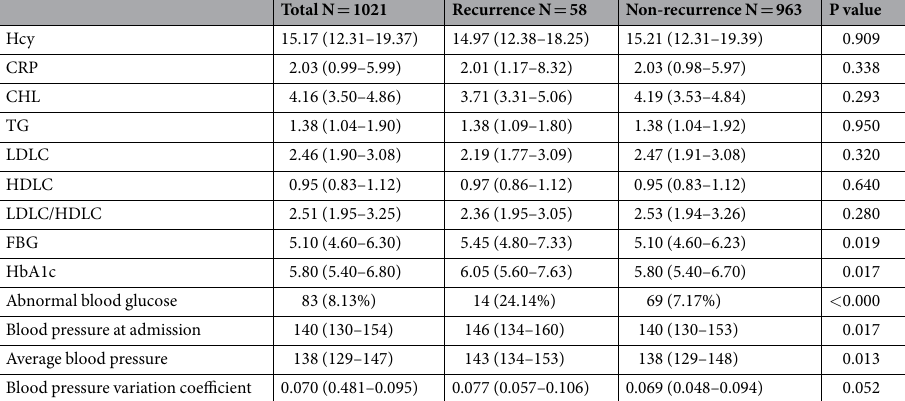
Table 4. Comparison of the serology results and blood pressure between the two groups of patients.